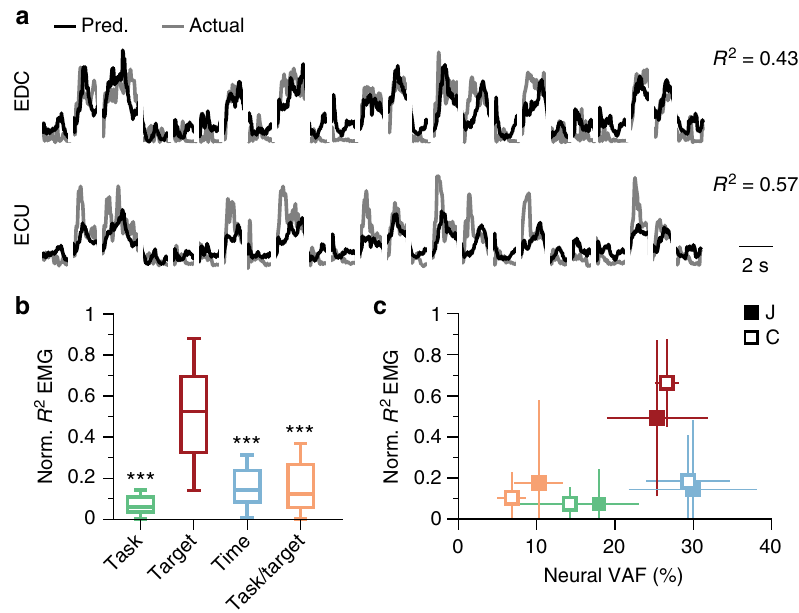
Fig. 6 Neural modes with task-independent activity as predictors to muscle activity. a Example EMG predictions for two muscles during 24 trials of the 1-D isometric task for one of the sessions from Monkey J. Predictions were based on the two leading target-related neural modes. b Normalized R 2 of the EMG predictions for four different decoders, each based on the two leading neural modes most strongly related to the corresponding dPCA behavioral parameter. Performance was averaged across all muscles, wrist tasks, and monkeys. Boxplots show median: center line; interquartile range: box; and data range (0.5 × interquartile range): whiskers. The *** denote P ~0 (two-sided Wilcoxon rank sum test). As reference, the R 2 of the decoders based on all 12 dPCA modes was 0.53 ± 0.21. c Normalized R 2 of the EMG predictions vs. the neural variance accounted for (VAF) by each of the four sets of neural modes identi fi ed with dPCA. Data averaged across all sessions and muscles for each monkey separately (legend). Squares: median± s.d.; color code as in b . Same data as in b and Fig.